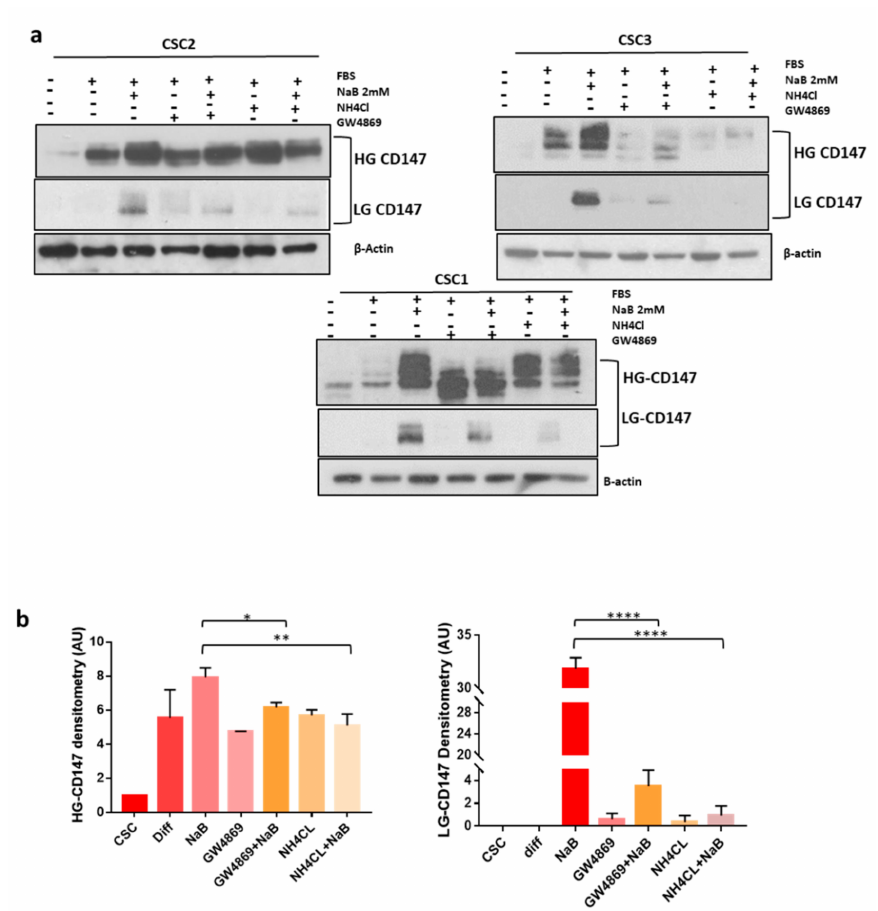
Figure 4. Inhibitors Of sEVs (small extracellular vesicles) Biogenesis Prevent CD147 Upregulation During The Di ff erentiation Of CR-CSC (colorectal cancer stem cell) Lines. ( a ) Simultaneous treatment of CR-CSCs lines induced to di ff erentiate with inhibitors of sEVs release (20 mM NH 4 Cl or 10 µ M of GW4869) prevented the increase of cellular CD147 expression and especially of LG-CD147 glycoform. ( b ) Bar charts show the densitometry and statistical analyses of CD147 bands (the data reported are the media of densitometry band of CD147 of three CR-CSCs: Re121, Sa41, U11). Data are representative of three independent experiments. *, p ≤ 0.05; **, p ≤ 0.005; ****, p ≤